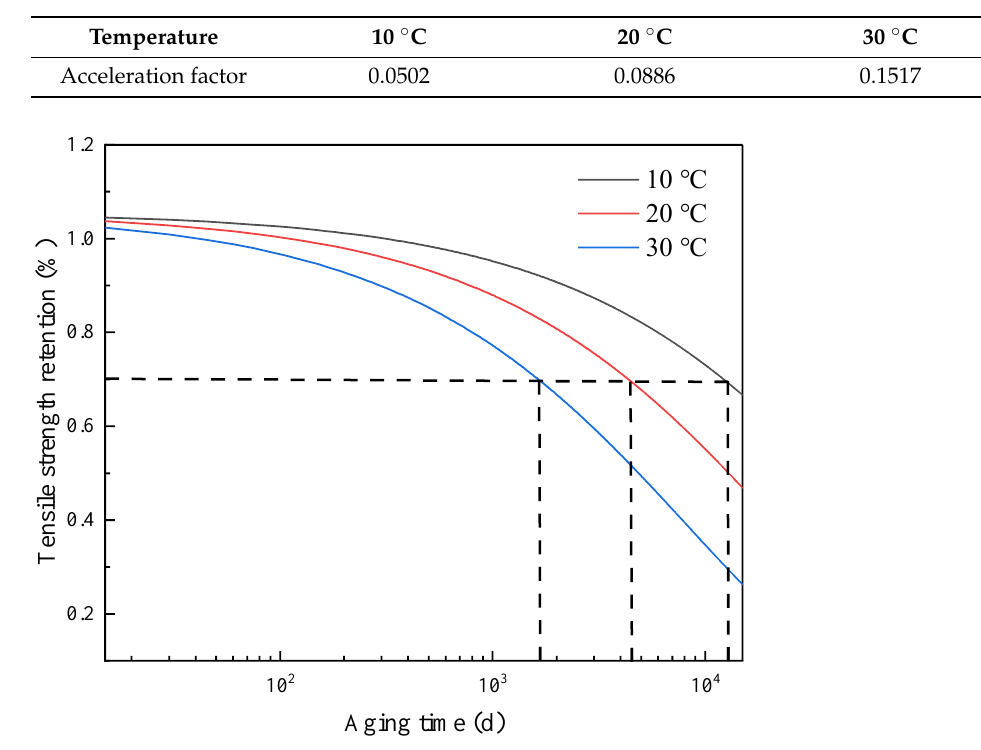
Table 3. Acceleration factor extrapolation results at low temperature.